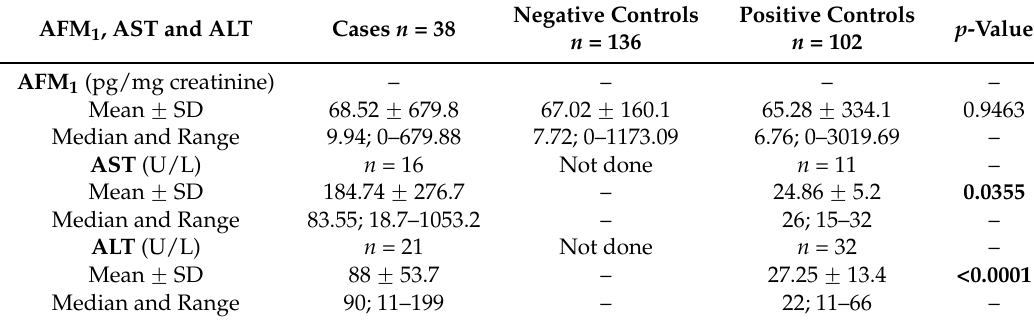
Table 2. Aflatoxin M 1 , aspartate transaminase (AST) and alanine transaminase (ALT) levels for the study groups. AFM 1 , AST and ALT